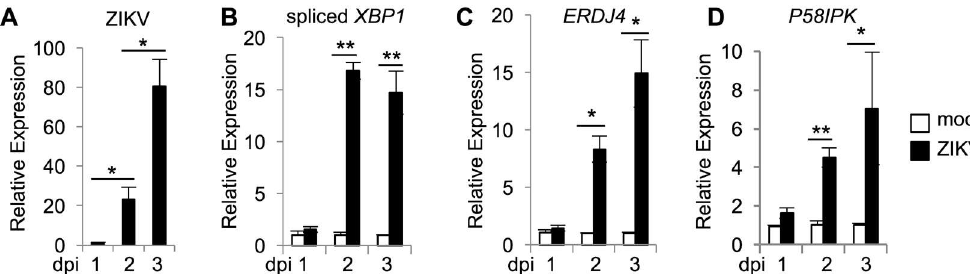
Figure 1. ZIKV infection activates IRE1α and induction of XBP1 targets. Cells were infected with ZIKV and RNA was harvested at the indicated number of days post infection (dpi). The relative mRNA abundance of ZIKV RNA ( A ) spliced XBP1 ( B ), ERDJ4 ( C ), and P58IPK ( D ) were determined by quantitative RT-PCR. Data are means ± SD of four replicates and are representative of at least two independent experiments. * p < 0.05, ** p < 0.001, by unpaired t test.